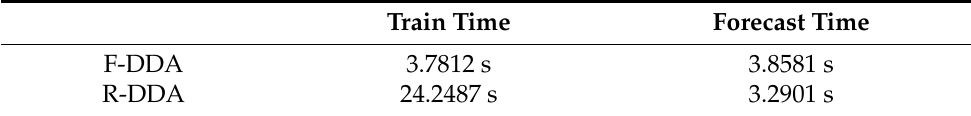
Figure 14. Trajectories of DA and DDA forecasting. It is the timesteps as Figure 11 for ∈ ( 1000,1176 ) . R-DDA (black dashline) vs. F-DDA (red dashline). Table 2. Run-time cost for F-DDA and R-DDA in training and forecasting of Lorenz